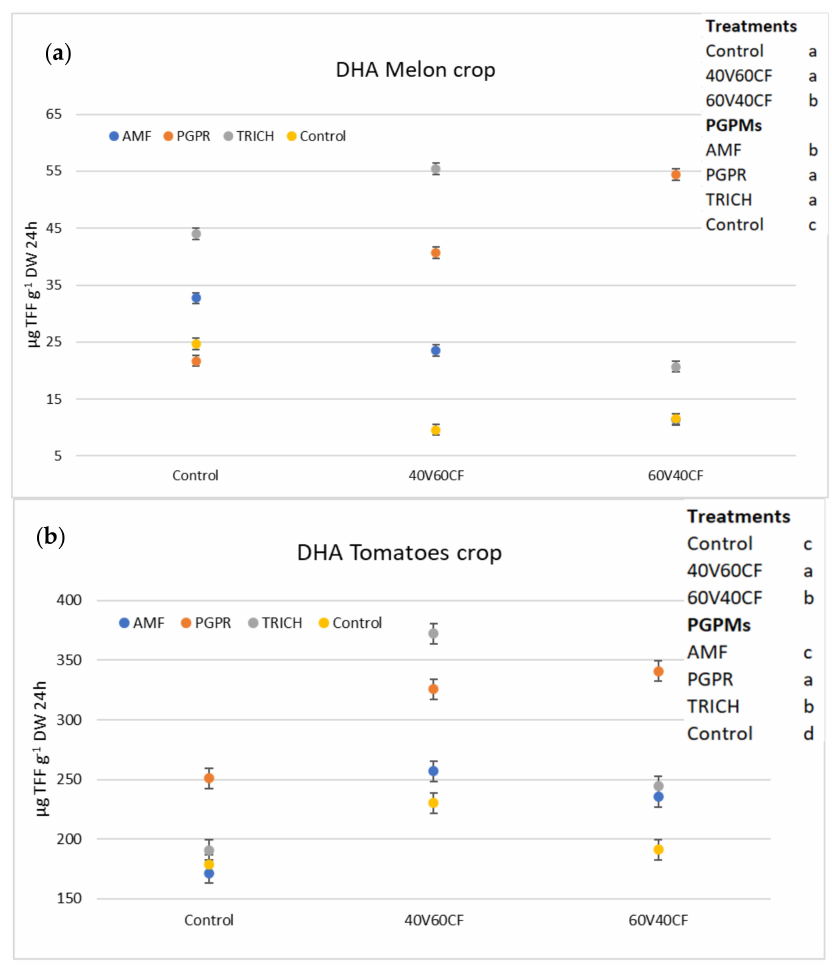
Figure 1. Dehydrogenase activity (DHA) between substrate treatments and PGPMs in ( a ) melon crop and ( b ) tomato crop. Substrates (% v / v ) of vermicompost (V) and coconut fiber (CF) (20V80CF (control), 40V60CF and 60V40CF). PGPMs (AMF (arbuscular mycorrhiza fungi), PGPR (plant-growth- promoting rhizobacteria), TRICH ( Trichoderma asperellum + Trichoderma atroviride ) and control (no PGPMs). Different letters in substrate legend represent differences ( p < 0.05) among substrate treatments. Different letters in PGPM legend represent differences ( p < 0.05) among plant-growth- promoting microorganisms